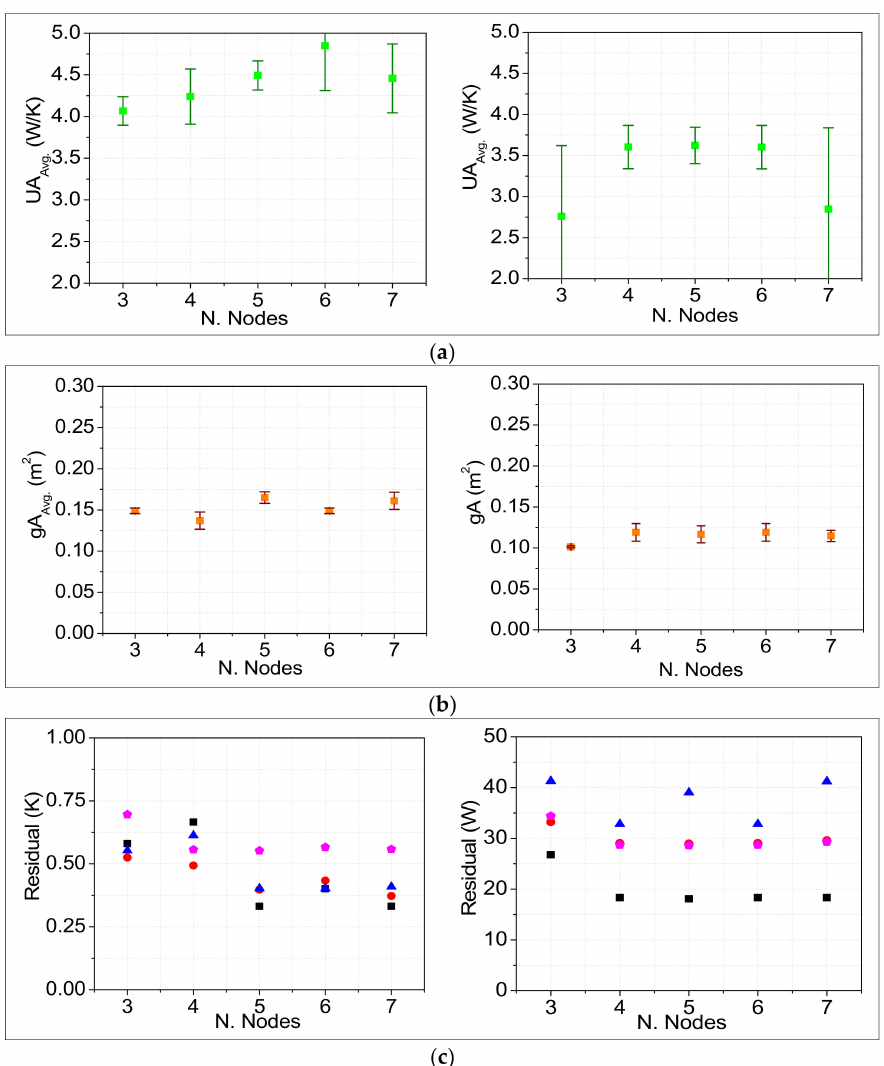
Figure 7. Whole building: results obtained using di ff erent candidate models. Left: using T i as output variable. Right: using P heating as output variable. ( a ) Average of UA for series a, b and c. ( b ) Average of gA for series a, b and c. ( c ) Residuals for series a, b, c and d. Series a in black, series b in red, series c in blue and pink for the full data series